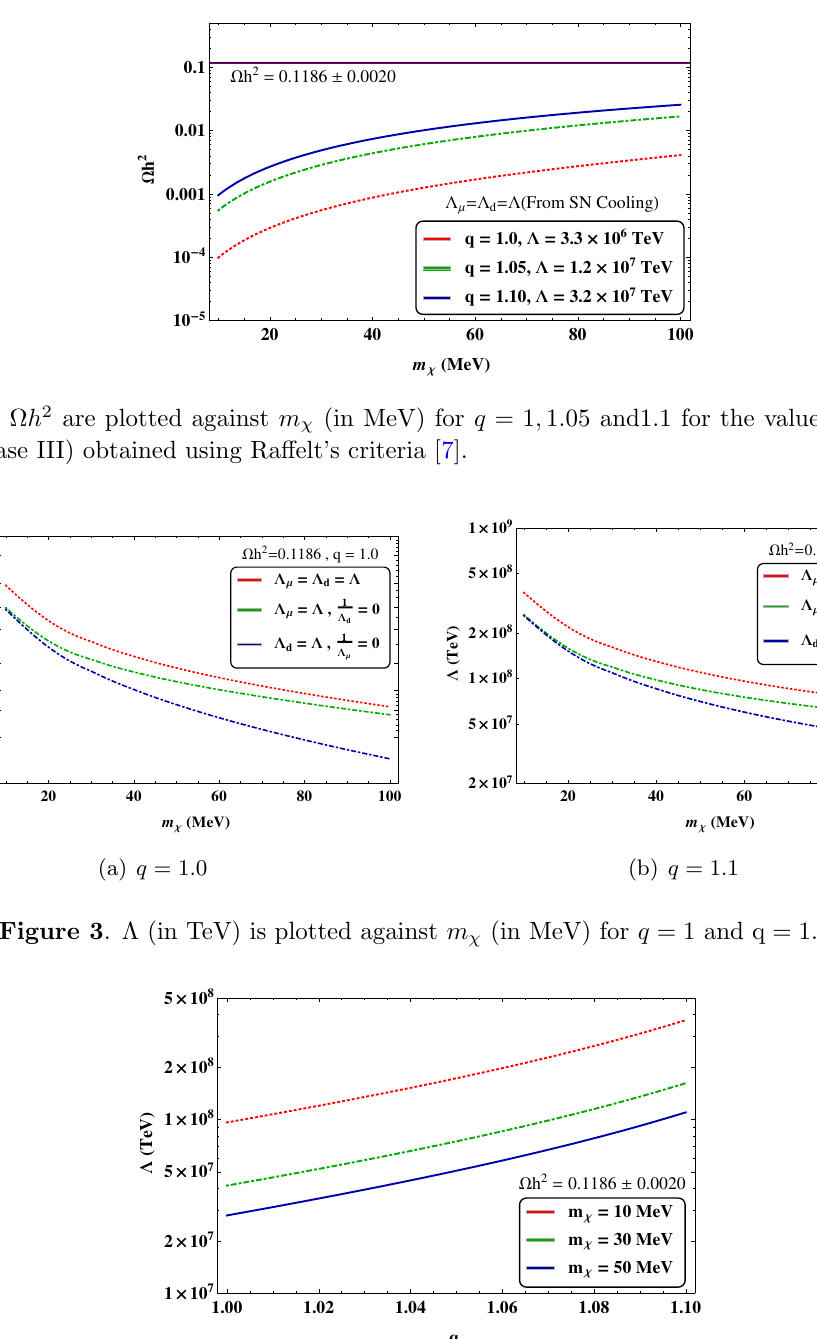
Figure 4 . (cid:3) (in TeV) is plotted against q for di(cid:11)erent m (cid:31) and (cid:10) h 2 = 0 : 1186 (cid:6) 0 : 0020.